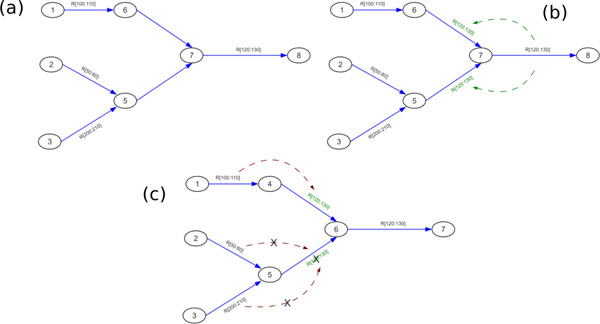
Showing the process of propagation and pruning, assuming τ = 15. All edges shown have an edge length of 10. Initially, we have the graph in (a), in which the edges (6,7) and (5,7) have no reference markers. The marker attached to edge (7,8) is propagated along incoming edges up to a distance of τ, resulting in the graph shown in (b). Note that the marker has been added to edges on both the top and bottom branch. Finally, in the pruning phase, each marker is checked for connectedness. On the top branch, the newly added marker is connected, while on the bottom branch, no adjacent marker connects, so the marker is pruned.